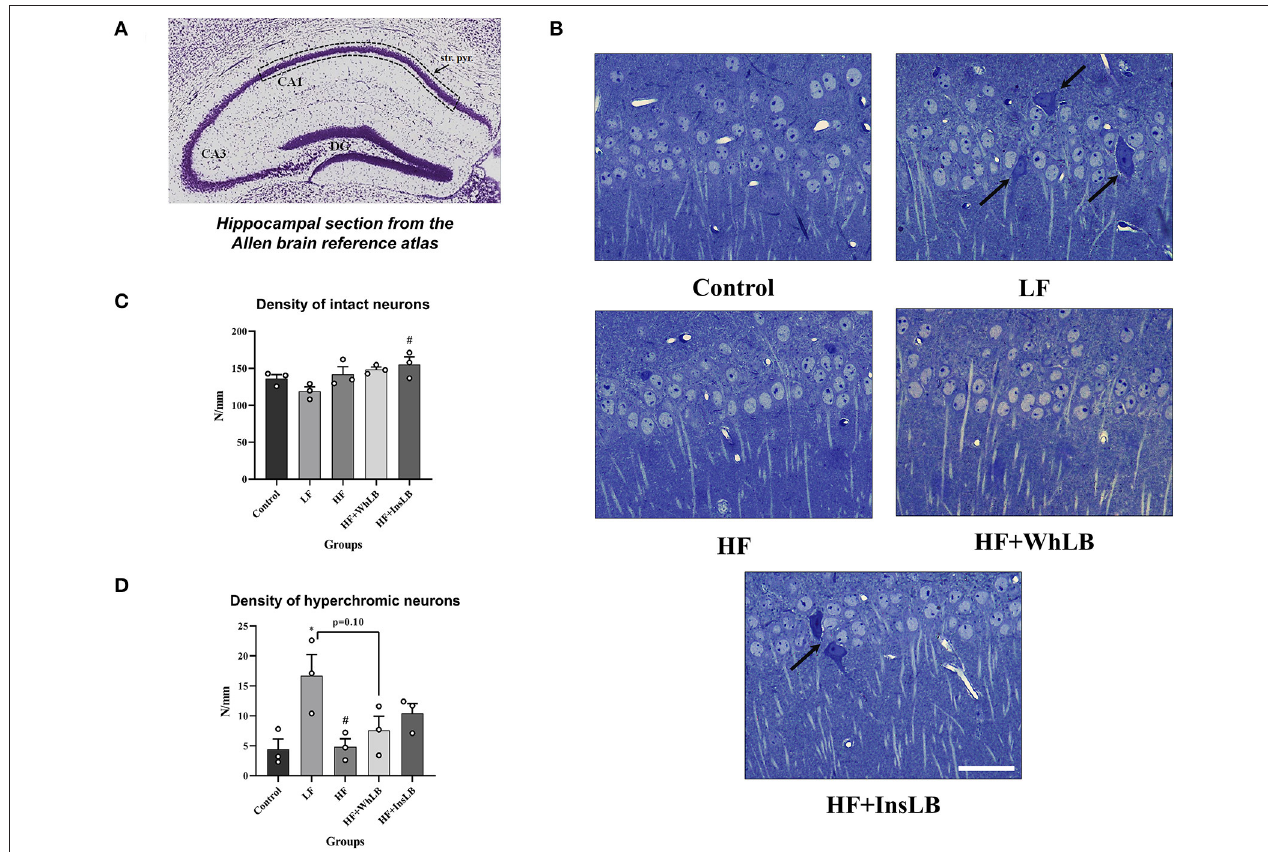
FIGURE 3 | Pyramidal neurons in the hippocampal CA1 area of ApoE–/– mice. (A) The reference image of the Nissl-stained coronal section of the dorsal hippocampus obtained from the Allen Mouse Brain Atlas. Dotted lines indicate the area of interest in the stratum pyramidale . (B) Methylene blue-stained semi-thin sections demonstrate the morphology of a pyramidal layer. Arrows point to hyperchromic damaged cells. (C) The density of intact neurons. (D) The density of hyperchromic pyramidal cells. Data are expressed as the Mean ± SEM ( n = 3/group). Comparisons among groups were performed with the one-way ANOVA, followed by Turkey’s post hoc test. * p < 0.05 indicates significant differences vs. control; # p < 0.05 indicates significant differences vs. LF. The scale bar corresponds to 20 µ